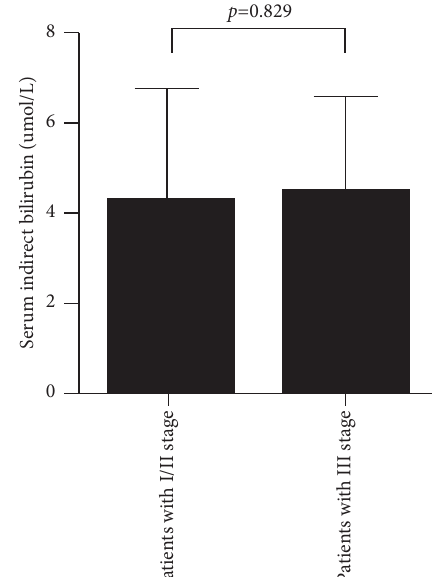
Figure 2: Te comparison of serum indirect bilirubin between stage I/II pneumoconiosis and stage III pneumoconiosis. Table 2: Te association between serum direct bilirubin and radiological severity according to the multiple linear-regression analysis. Unstandardized coefcients Standardized coefcients t p value B Standard